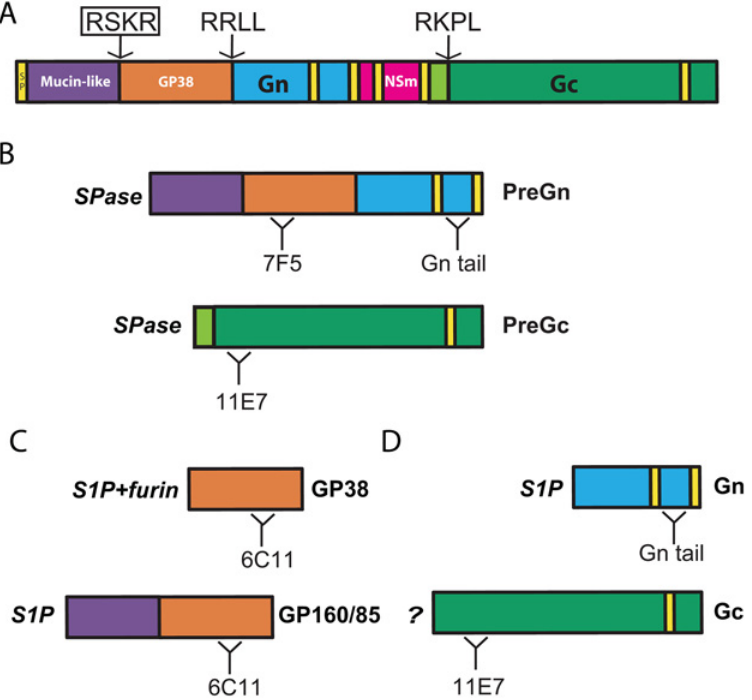
Fig 5. CCHFV M segment polyprotein processing. (A) Signal peptide (SP) and predicted transmembrane domains are indicated in yellow. Arrows indicate locations of cleavage motifs recognized by mammalian convertases. The RSKR motif (boxed) was mutated to ASKA to block processing. (B) Signal peptidase (SPase) cleavages result in production of Gn and Gc precursors (PreGn and PreGc). Binding regions of the anti-glycoprotein antibodies used in this study (7F5, Gn tail, 11E7, and 6C11) are also represented. (C) Mature glycoprotein products (GP160/85, GP38, Gn, and Gc) resulting from mammalian convertase cleavage. (D) S1P cleavage is required for the production of GP160/85 and Gn, while GP38 requires cleavage by both S1P and furin-like PCs. An unidentified mammalian convertase is required for PreGc maturation to